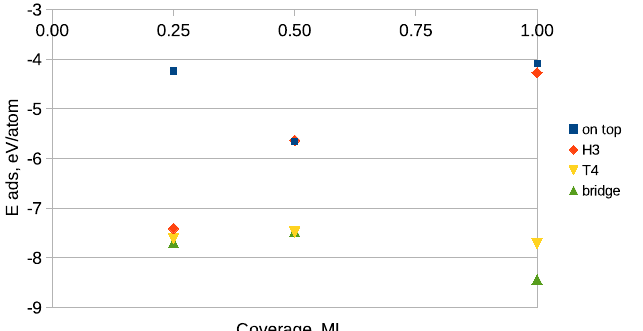
Figure 6. Adsorption energies vs. coverage on the Ga-terminated surface. Starting adsorption sites are shown in the legend